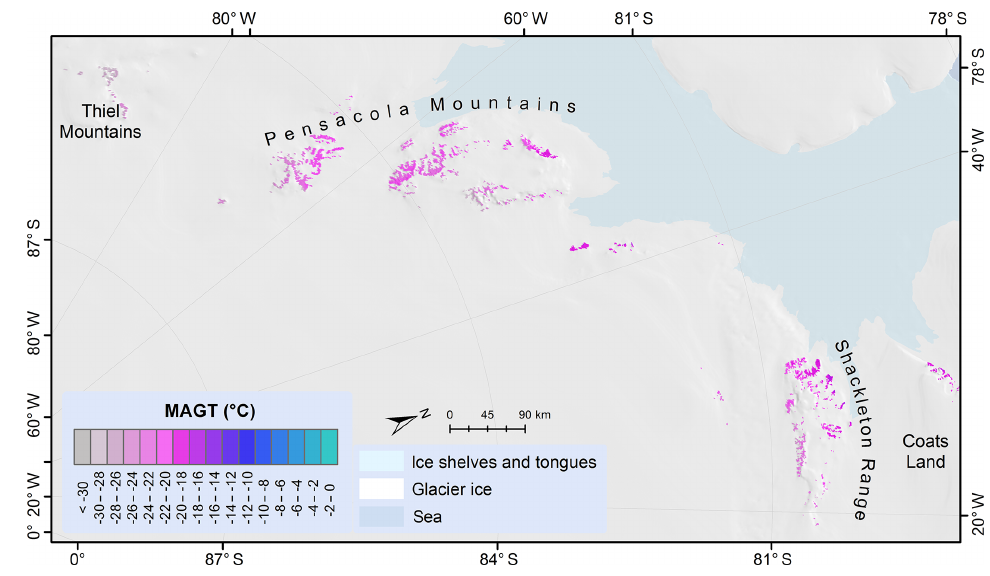
Figure 7. Permafrost temperature map of the Transantarctic Mountains west of the 90 ◦ meridian. See Fig. 1 for